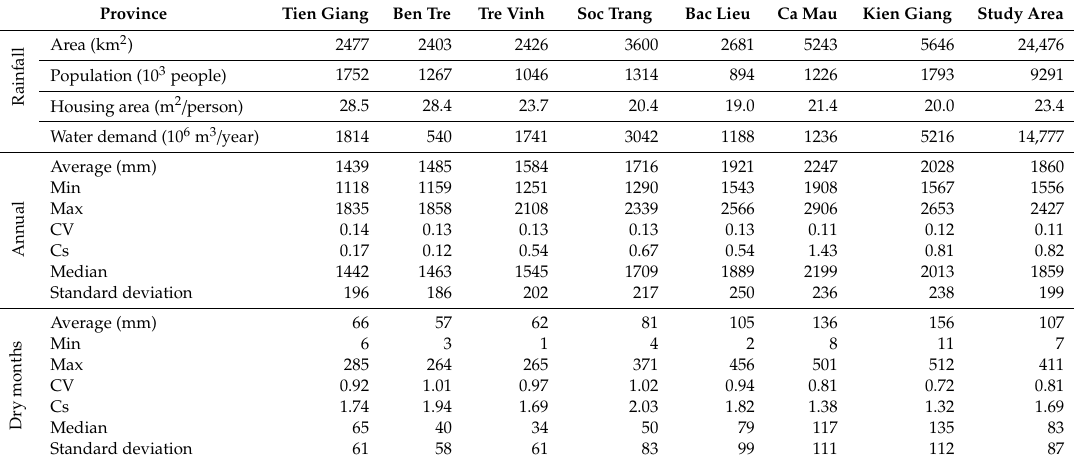
Figure 6. Annual distribution of rainfall in coastal provinces of the VMD in the average year (50%). Table 1. Data on annual rainfall and rainfall in the four dry season months in coastal provinces of the Vietnamese Mekong Delta (VMD), according to rain gauge data,